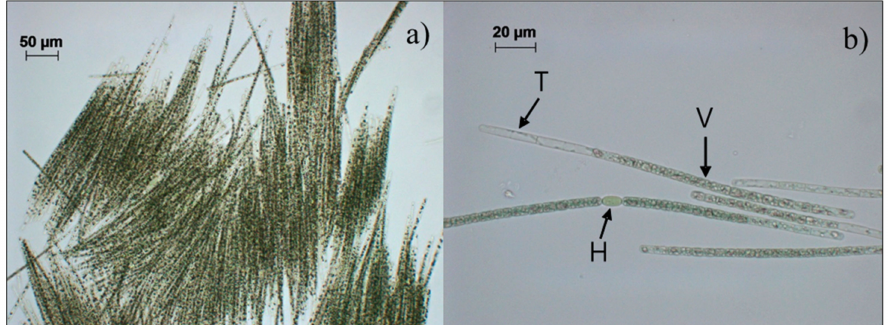
Figure 2. Microscope images of Aphanizomenon flos-aquae NRERC-006: ( a ) band-like fascicles, ( b ) single trichomes with vegetative cells (V), heterocytes (H), and typical apical cells